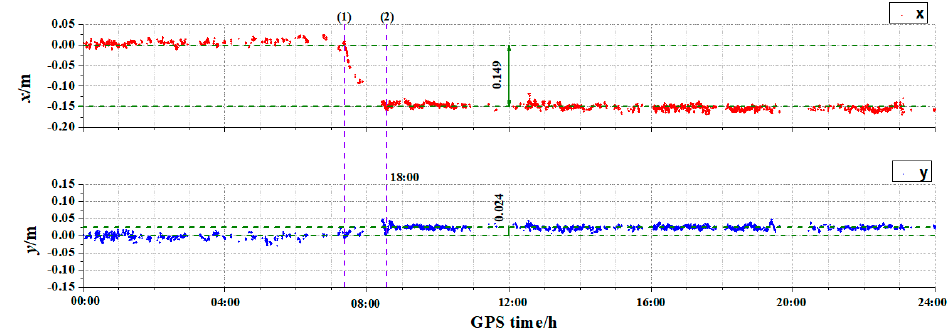
Figure 19. Real-time tower deflection of QNT1. The vertical line ( 1 ) represents the start moment of saddle pushing and the vertical line ( 2 ) represents the end moment of saddle pushing. The deformation of the x-direction is shown in red and y is shown in blue.